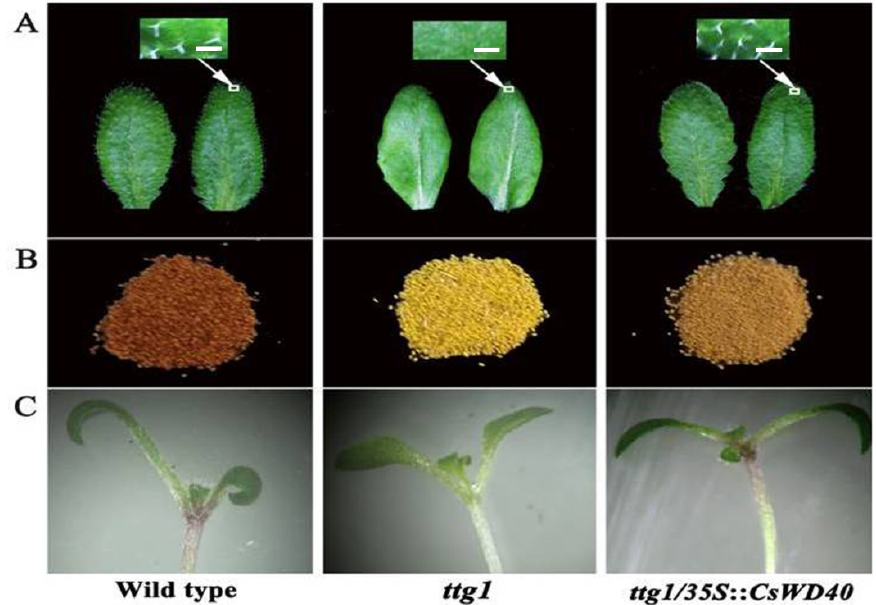
Figure 2. CsWD40 complements the phenotypes of Arabidopsis ttg1 mutant. ( A ) Leaf trichome occurrence. Bar = 0.5mm ( B ) Seed coat pigmentation. ( C ) Trichome seedling.